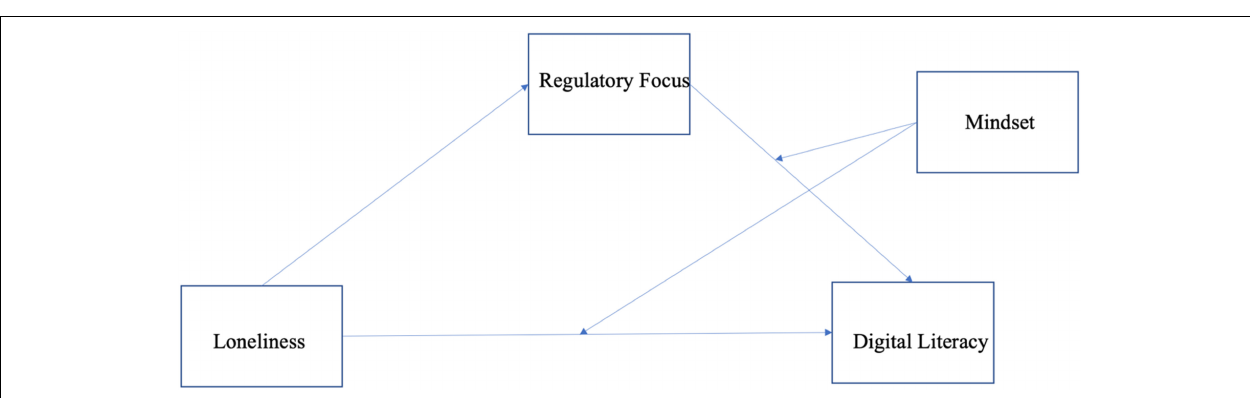
FIGURE 2 | Moderated mediation effect on digital